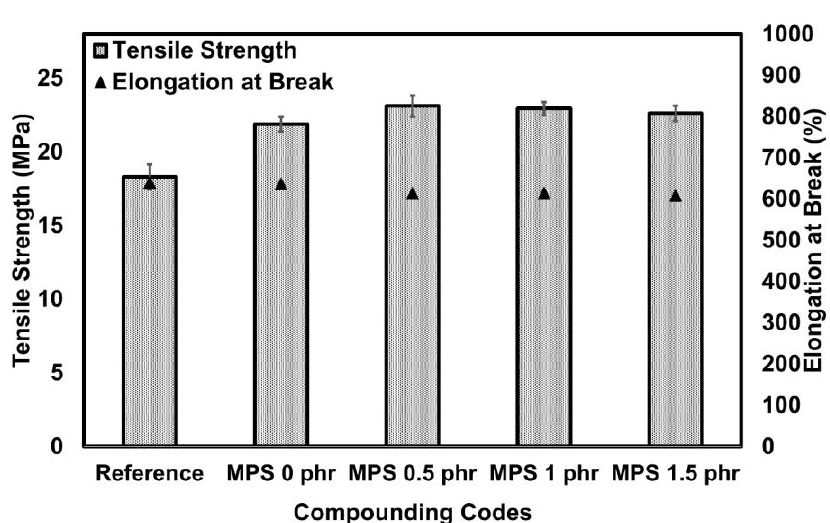
Figure 5. Tensile strength and elongation at break of NR/HNT composites in the presence of MNR/MPS as dual compatibilizers.